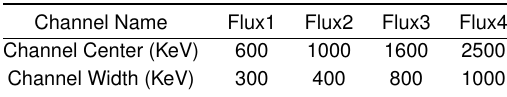
Table 1. Energy channel description of the Beidou MEO data showing the center and width of four